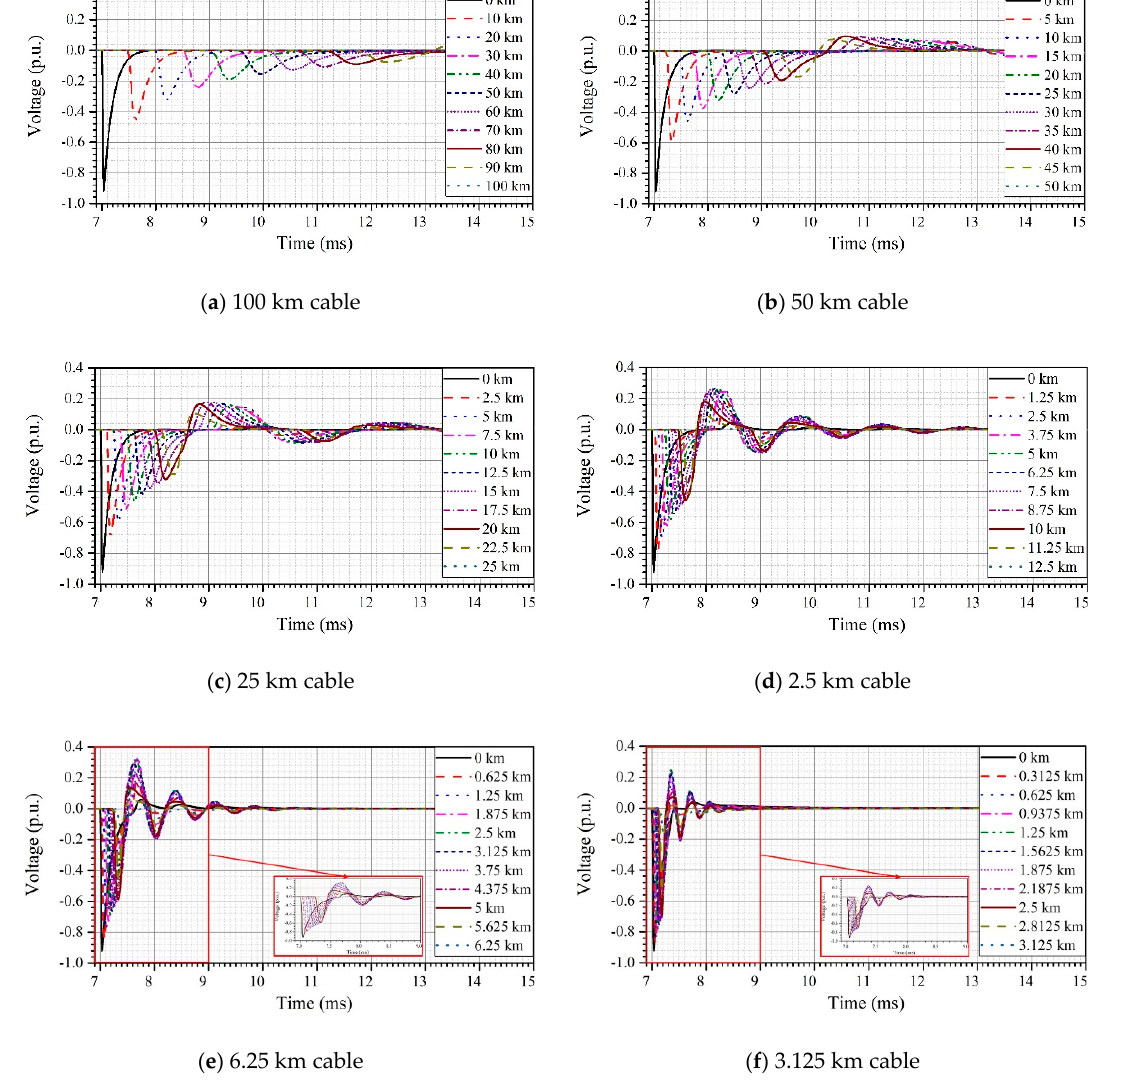
Figure 17. Sheath-ground overvoltage at ten equally spaced intervals along the length of the cable (3.125–100